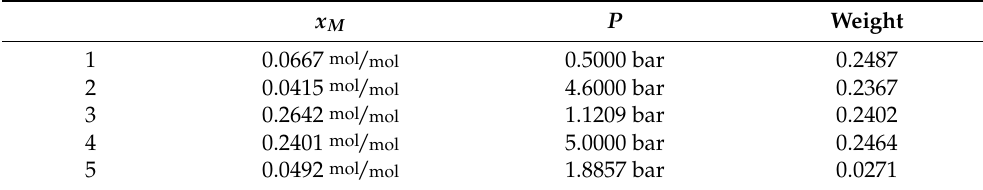
Table 3. Optimal designs ξ ADAGPR computed with the ADA-GPR for the flash with a methanol-water input